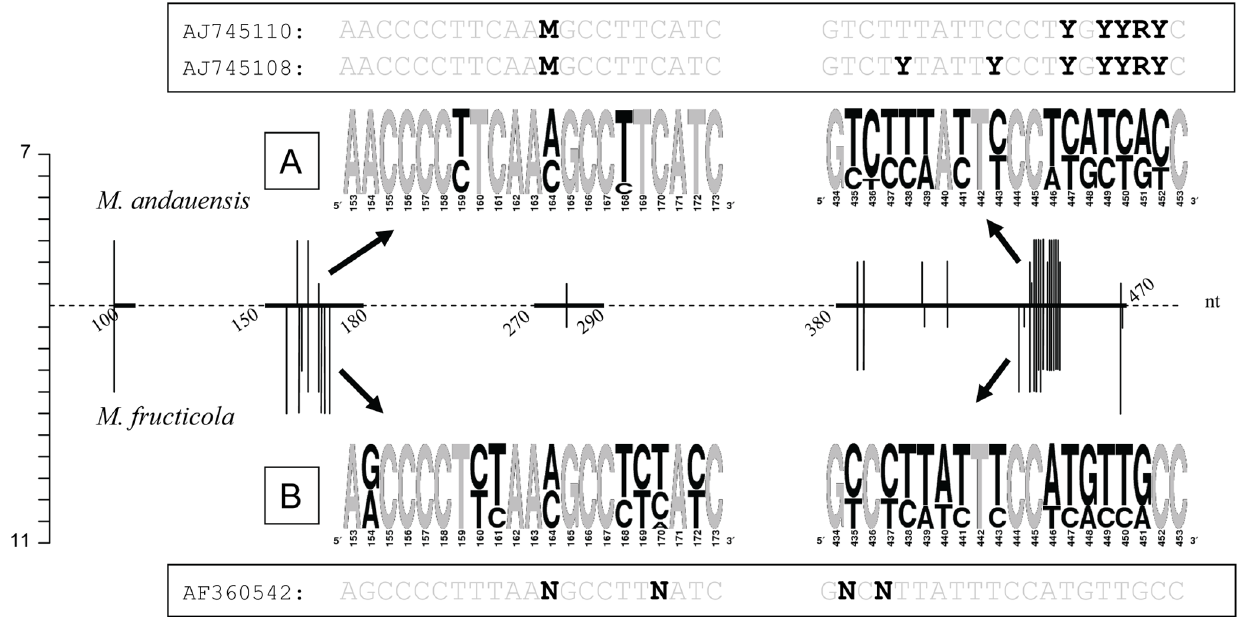
Figure 1. Variable sites in the D1/D2 domains of the type strains of M.andauensis and M.fructicola . The graph in the middle of the figure shows the location of the variable sites. The horizontal line represents the D1/D2 domain. For better orientation, the distance (in number of nucleotides) of certain sites from the 3 9 end of the NL1 primer is shown. Each variable site is marked with a vertical line above ( M. andauensis ) or below ( M. fructicola ) the D1/D2 line. The height of a vertical line shows the number of cloned alleles which had a nucleotide at that position different from the nucleotide of the majority of the M. andauensis or the M. fructicola clones. The sequences of the regions with high density of variable sites are shown in Weblogos (A and B). In the Weblogos, the nucleotides of the variable sites are highlighted with black colour. The framed sequences are the corresponding segments of Genbank sequences of the type strains of M. andauensis and M. fructicola . The M. andauensis frame also contains the other sequence of the species available in the database. In the framed sequences the symbols of ambiguous nucleotides are highlighted with black